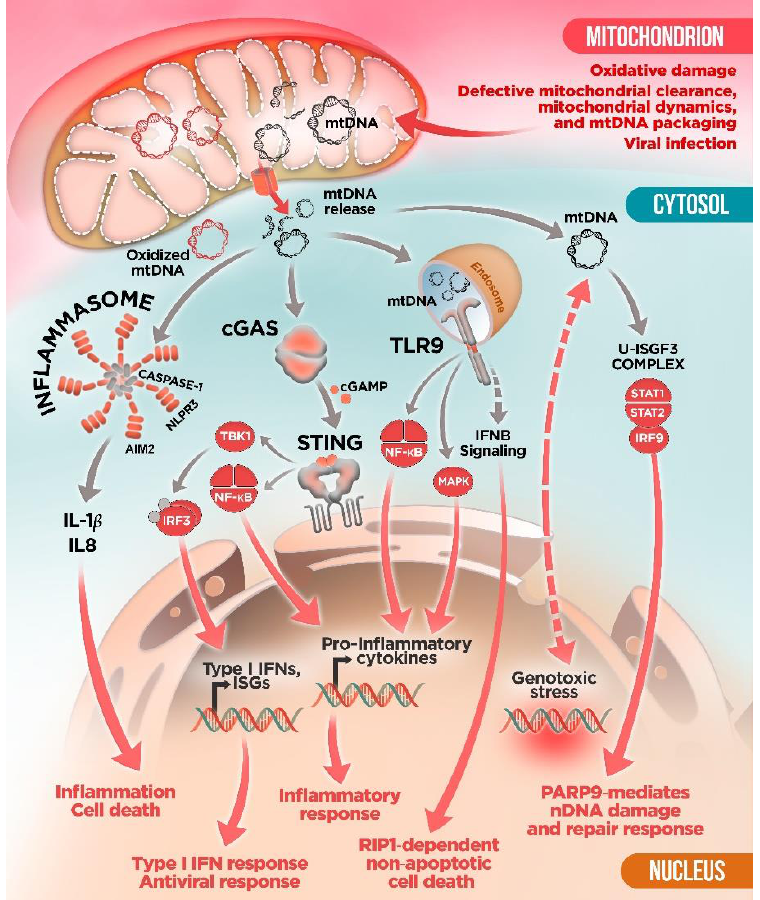
Figure 1. mtDNA-activated immune pathways. Under mitochondrial insults (oxidative stress, infections, etc.) or mitochondrial quality control impairment, mtDNA is released to the cytosol where it engages different receptors, activating inflammatory and innate immune signaling pathways. From the left: Oxidized mtDNA stimulates inflammasome activity leading to caspase-1-mediated maturation of pro-inflammatory IL-1β and IL18; mtDNA activates the cGAS–STING pathway triggering interferon response via IRF3 and NF-κB; TLR9 recognizes mtDNA, resulting in activation of NF-κB or MAPK and pro-inflammatory cytokines production. mtDNA also promotes non-apoptotic cell death trough TLR9/IFN-β signaling. Genotoxic stress and DNA repair response are also mediated by cytosolic mtDNA.